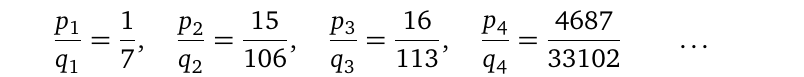
Figure 6: The non-heating parameters for g α = p / q with q (cid:182) 40. Black dashed lines correspond to I =